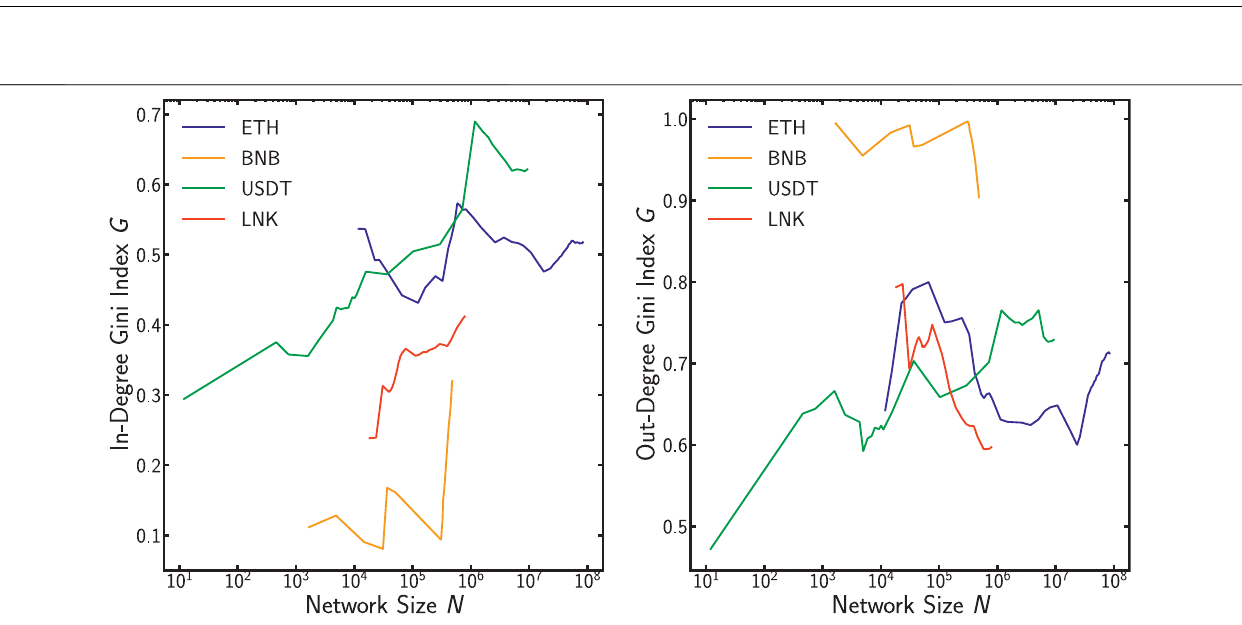
FIGURE12| We plotthe network sizeasanumber ofnodes N against theGini index G forthe in-degree distribution and out-degree. We take monthlysnapshots.